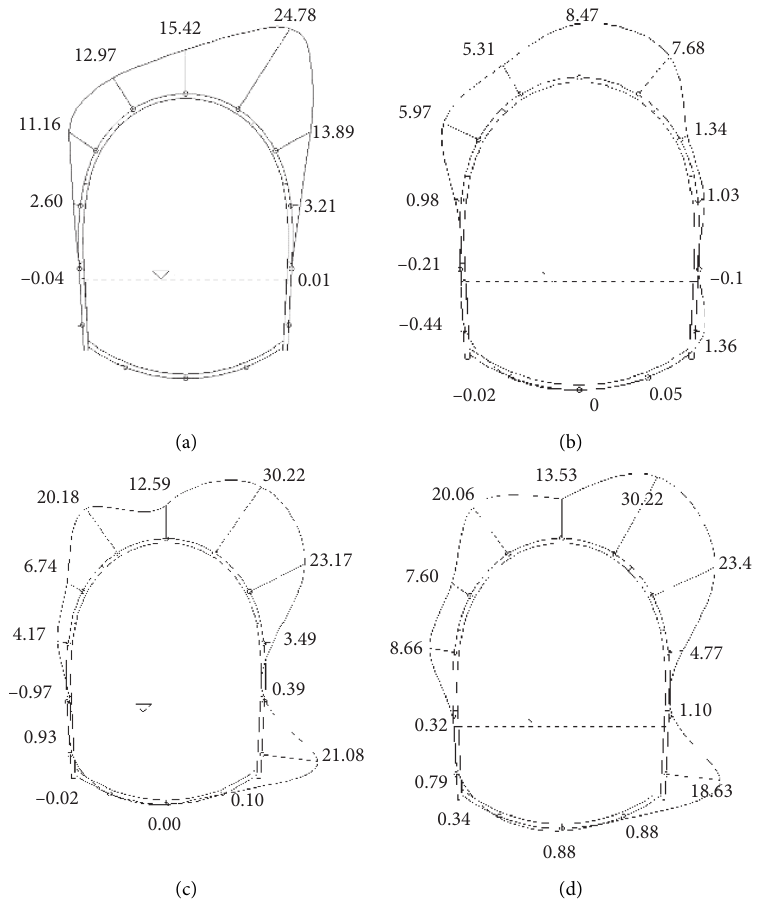
Figure 14: Distribution of shotcrete stress of initial support on the cross-section A (unit: MPa) (a) 7 days after excavation, (b) excavation of lower bench and inverted arch, (c) before construction of secondary lining, and (d) after deformation stabilization.